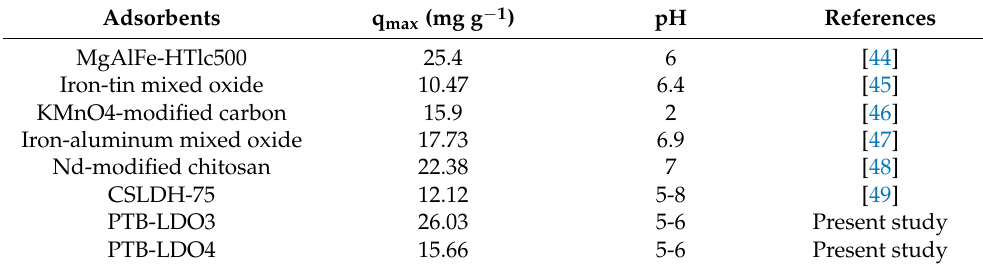
Table 3. Comparison of adsorption capacity of PTB-LDO3 and PTB-LDO4 with different adsorbents.